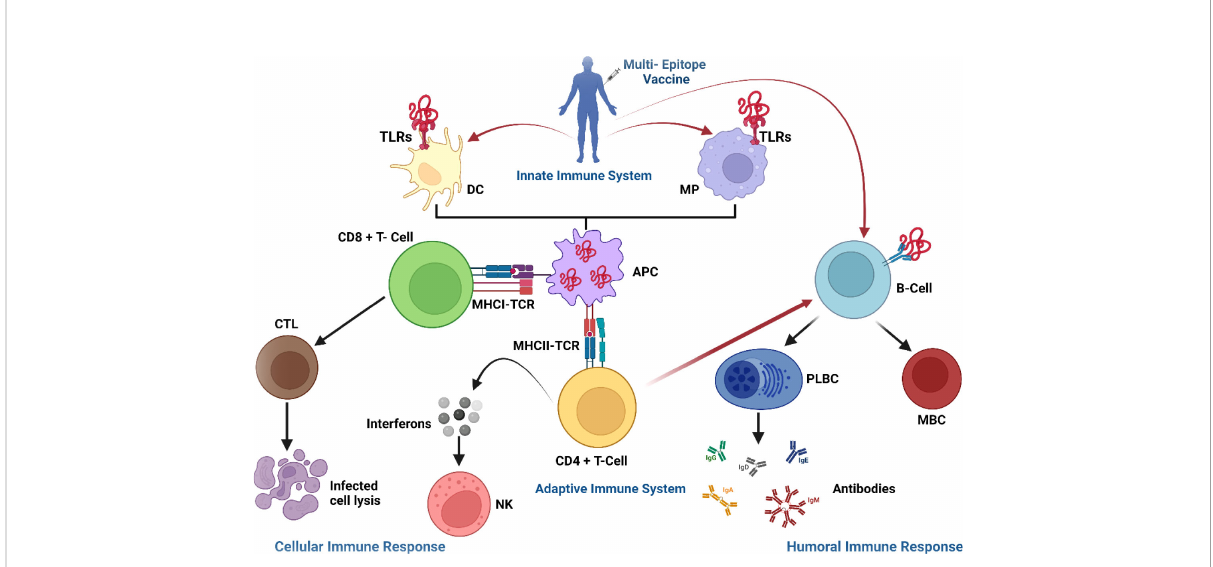
FIGURE 10 Proposed immune route in response to a multiepitope-based subunit vaccine in the host. The vaccine enters the cell through toll-like receptors (TLRs) and attaches to dendritic cells (DC) and macrophages (MP), triggering an innate immune response. The vaccine ’ s epitopes are then digested by antigen-presenting cells (APC) and presented to T-cells, which triggered an adaptive immunological response. T-cells activate other immune cells or destroy infected cells directly (cellular immune response), whilst plasma B-cells (PLBC) create antibodies to neutralize viruses and memory B-cells (MBC) preserve all the information needed to mount a powerful immune response in the event of re-infection (humoral immune response). CD, cluster of differentiation; MHC, major histocompatibility complex; TCR, T-cell receptors; CTL, cytotoxic T lymphocytes; IFNs, interferons; NK, natural killer cells; PLBC, Plasma